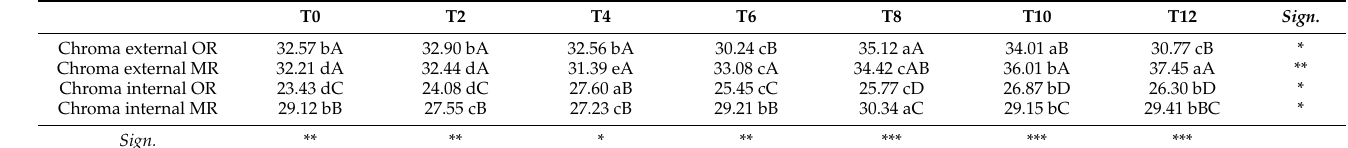
Table 4. Colours and chroma values of Cantuccini biscuits made using the original recipe (OR; 50% cow’s butter/50% margarine) and modified recipe (MR; 70% EVOO/30% cow’s butter). One-way ANOVA, means ± SD (of six replicates) in the same row followed by a different letter are significantly different according to Tukey’s test; * p < 0.05; ** p < 0.01; *** p < 0.001. Means in the same column are distinguished by capital letters. Means in the same line are distinguished by small letters. T0 T2